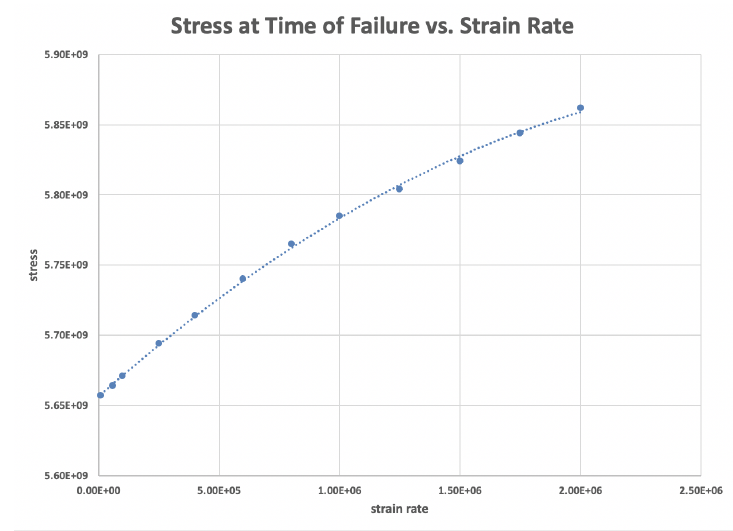
Figure 5. The stress component σ yy at time of failure is plotted vs. strain rate. The ensemble size is 100 and the process zone is 10% of the crack radius. That stress increases slightly with strain rate, but is essentially constant. The curve is captured by a quadratic trendline with R 2 = 0.999.